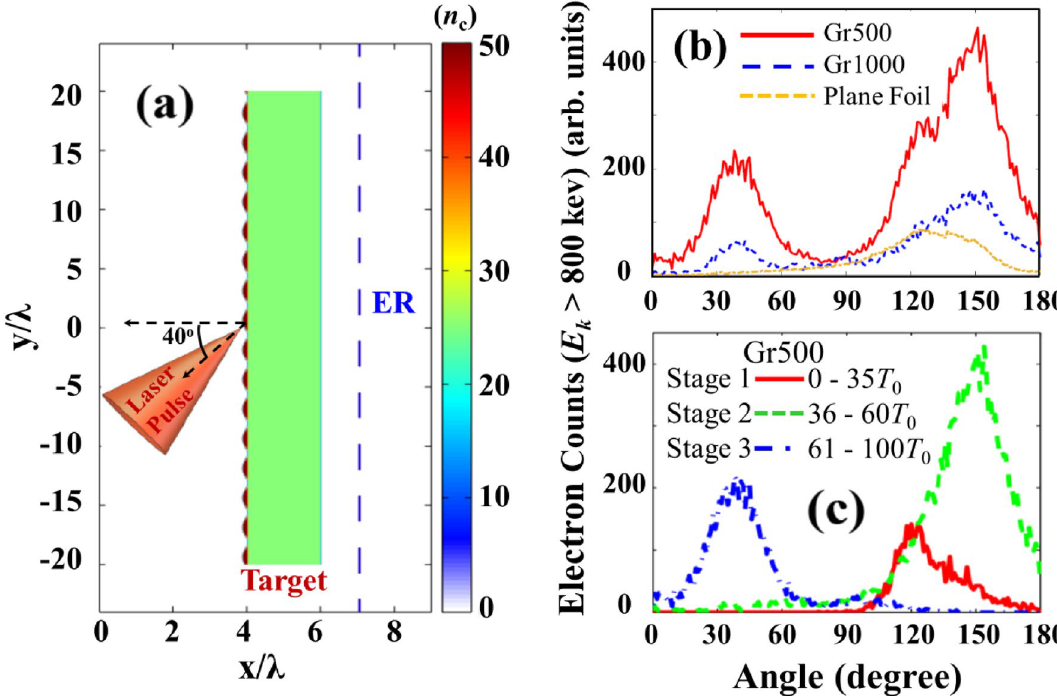
Figure 5. ( a ) Schematic of the simulation setup. The colorbar represents the plasma density ( n c ). ER is an electron recorder for diagnosis. The incidence angle is 40° in accordance with the experimental setup. ( b ) Angular distribution of fast electrons (E k > 800 keV) recorded by ER for plane foil, Gr500, and Gr1000. ( c ) Electron emission detected during all three stages of laser interaction time profile for Gr500. Stage 1: 0–35 T 0 (red curve—representing laser rising edge); Stage 2: 36–60 T 0 (green curve—after the laser peak until the upper-forward electrons fade away), Stage 3: 61–100 T 0 (blue curve—after the Stage 2 until the all the detectable electrons vanish). The moment in each stage here is several T 0 later than the laser loading time due to the propagation delay (i. e., t = 30 T 0 is the moment at which the laser peak impinges on the target. However, about additional 5 T 0 is required for electrons propagating from the target surface to ER, hence the corresponding time for electrons being detected is t = 35 T 0 Material, Fig. S2). The angularly resolved electron spectra show electron temperatures (75 ± 1 and 209 ± 14) keV, (63 ± 1 and 356 ± 44) keV, and 98 ± 1 keV at 40°, 90°, and 150°, respectively (Supplementary Material, Fig. S2). The